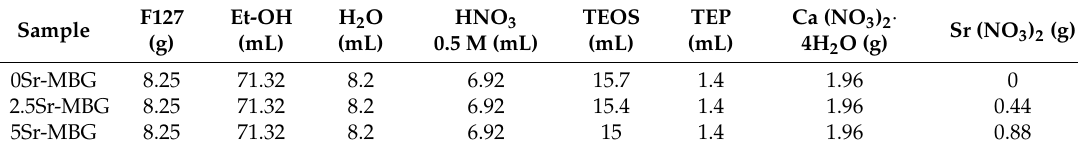
Table 1. Amounts of reactants used for the synthesis of the mesoporous bioactive glasses (MBGs). F127 Et-OH H 2 O HNO 3 Sample (g) (mL) (mL) 0.5 M